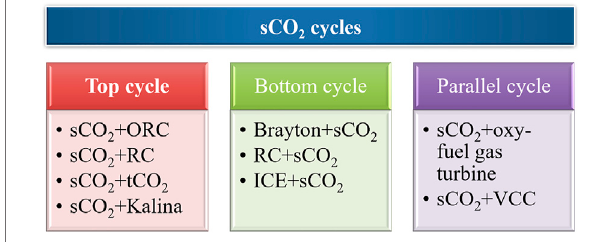
FIGURE 9 | Possible approaches for the combined system based on sCO 2